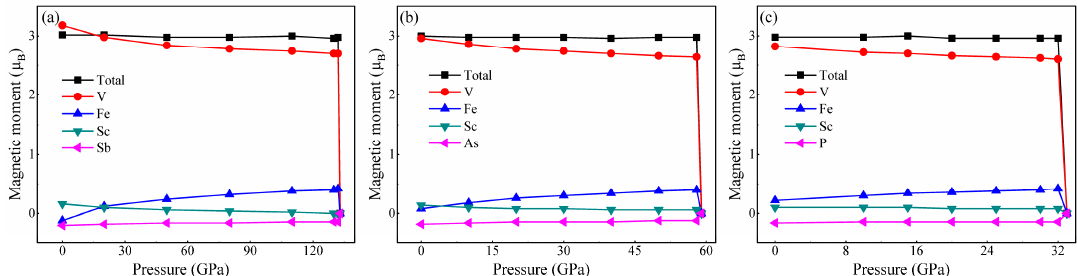
Figure 10. Magnetism changes of type-I ( a ) VFeScSb, ( b ) VFeScAs, and ( c ) VFeScP at various pressures.